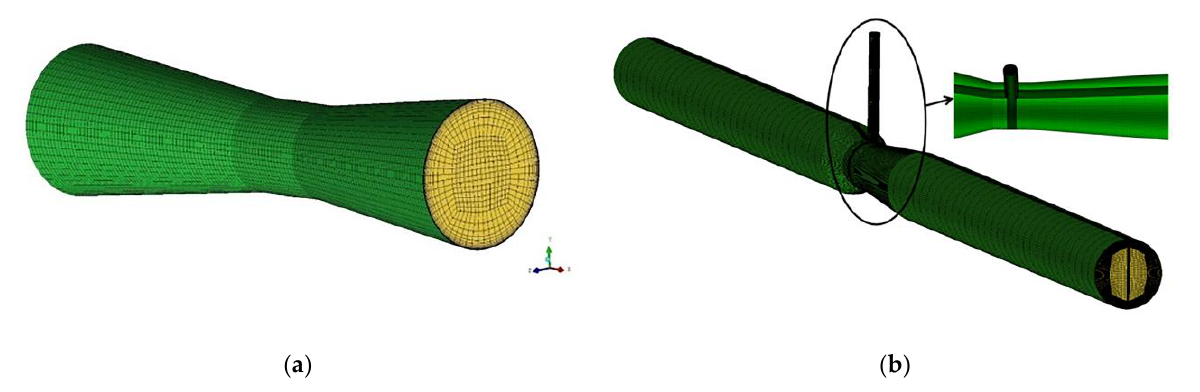
Figure 4. Velocity distribution along z -direction in cross-flow.